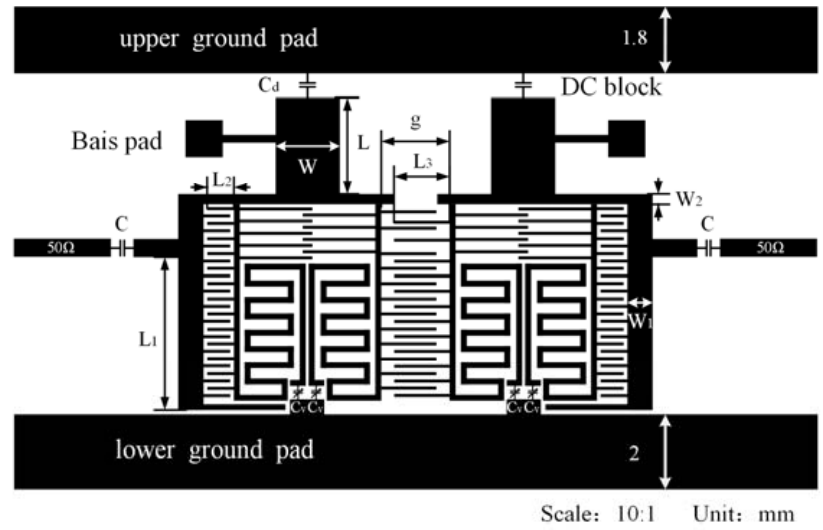
Figure 4. The proposed high-temperature superconducting (HTS) tunable bandpass filter with four poles. The grounding technique is essential for the design of an HTS-tunable filter. The resonant frequency is influenced by the HTS GP, which is influenced by its width. The upper HTS GP shown in Figure 4 is designed with a dimension of 21.6 × 1.8 mm 2 , whereas the lower HTS GP has a size of 21.6 × 2 mm 2 with negligible impact on the RF performance. The soldering bias pad, with dimensions of 1 × 1 mm 2 , is connected to the resonator. This connection is achieved using a high-impedance line with a width of 0.2